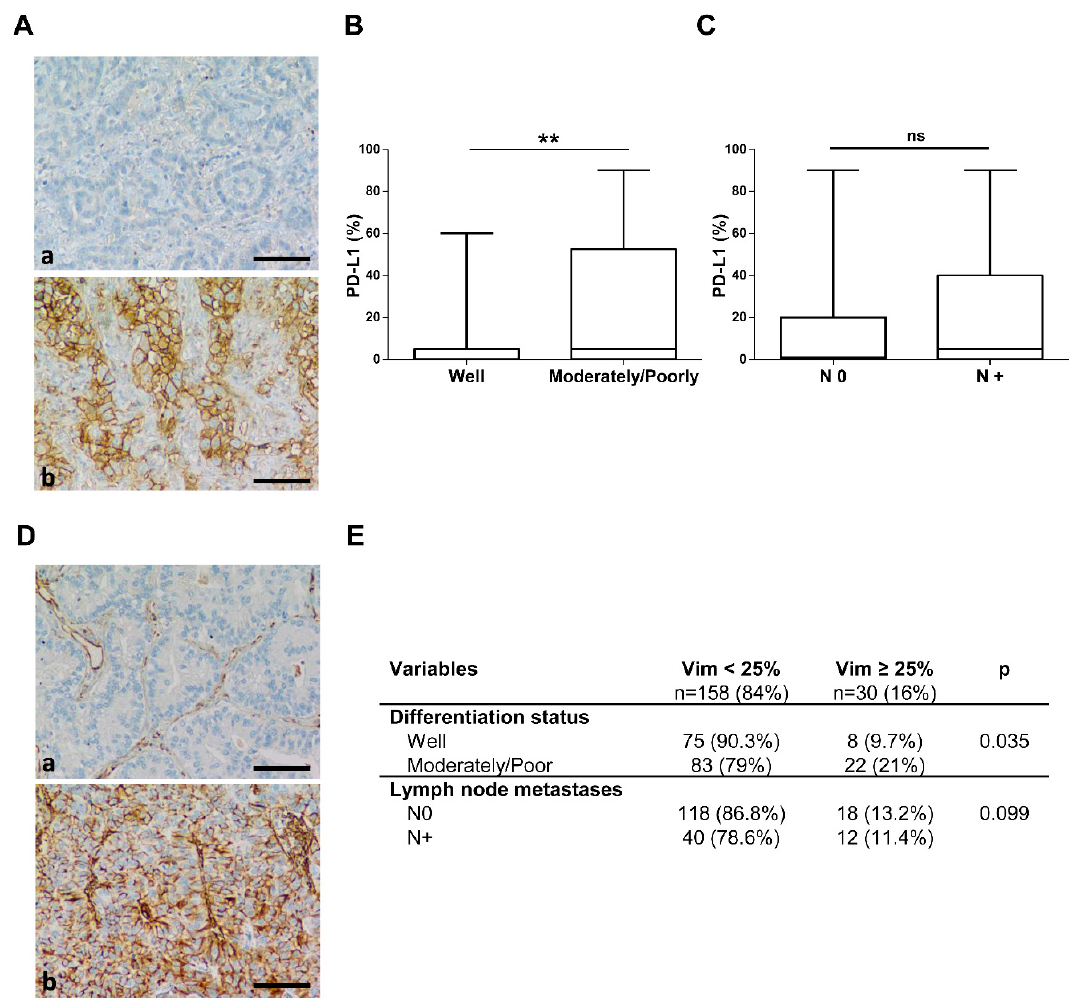
Figure 1. PD–L1 and vimentin expressions in NSCLC. ( A ) Illustration of PD–L1 immunostaining performed on well-differentiated ( a ) and on poor-differentiated adenocarcinomas ( b ). (Bar = 60 µm). ( B ) PD–L1 expression by tumor differentiation degree. Tumors samples divided into well ( n = 83) and moderately/poorly ( n = 105) differentiated. ( C ) PD–L1 expression by lymph node status. Tumors samples distributed by lymph node invasion. ( D ) Illustration of vimentin immunostaining performed on well-differentiated ( a ) and on poor-differentiated adenocarcinomas ( b ) (Bar = 60 µm). ( E ) Vimentin expression by tumor differentiation degree and lymph node status. Data in the boxplots are presented as median ± 95 percentile and table of contingency. ** p < 0.01.